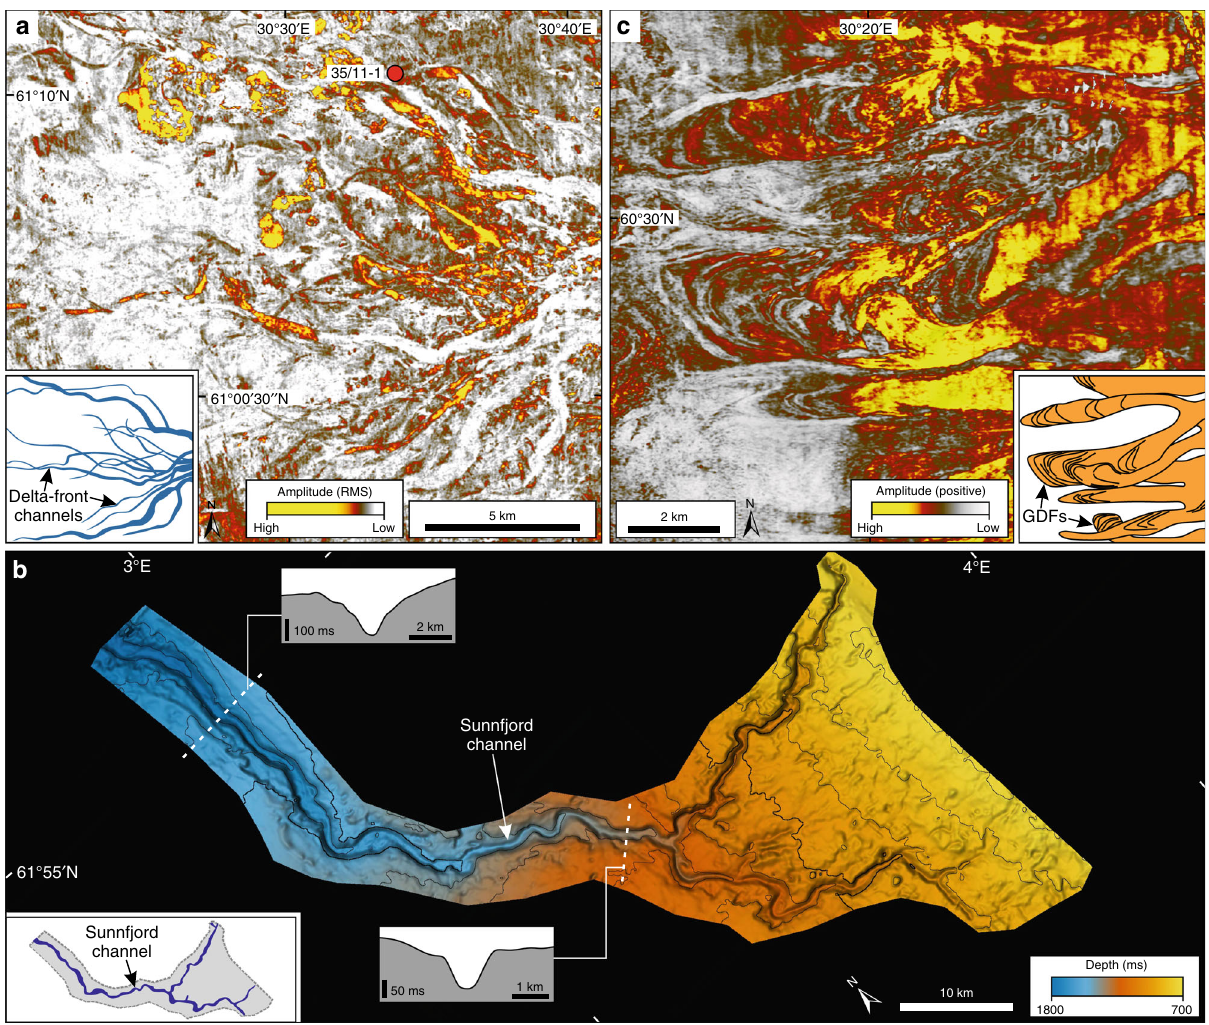
Fig. 2 Examples (main panels) and interpretations (insets) of geomorphological features extracted from 3D seismic data. a RMS-amplitude map of delta-front channels in the Utsira Formation east (location in Fig. 1b). Amplitudes are extracted from a 12 ms window around a smooth intra-Utsira east surface where high amplitude values are shown in red and yellow. b Structure map of the base of the 100 km-long submarine Sunnfjord channel (c.i. = 100 ms) (location in Fig. 1a). The channel de fi nes the base Naust horizon (base-Quaternary) and is mainly in fi lled by early Quaternary glacigenic debris- fl ows. c Maximum amplitude map of glacigenic debris- fl ows (GDFs) on early Quaternary clinoform (ii) (location in Fig. 1b). Maximum amplitudes are extracted from a window 30 – 10 ms above surface (ii) (red and yellow are high positive amplitude